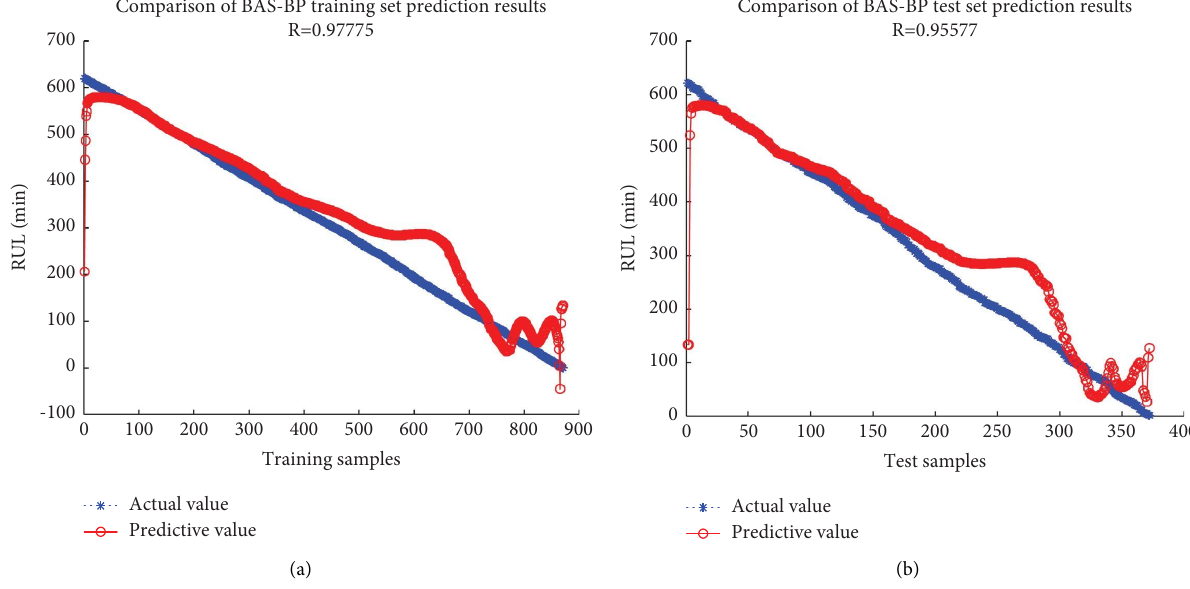
Figure 12: BAS-BP model prediction results of vibration signal. (a) Training set. (b) Test set. Comparison of BAS-BP training set prediction results R=0.97845